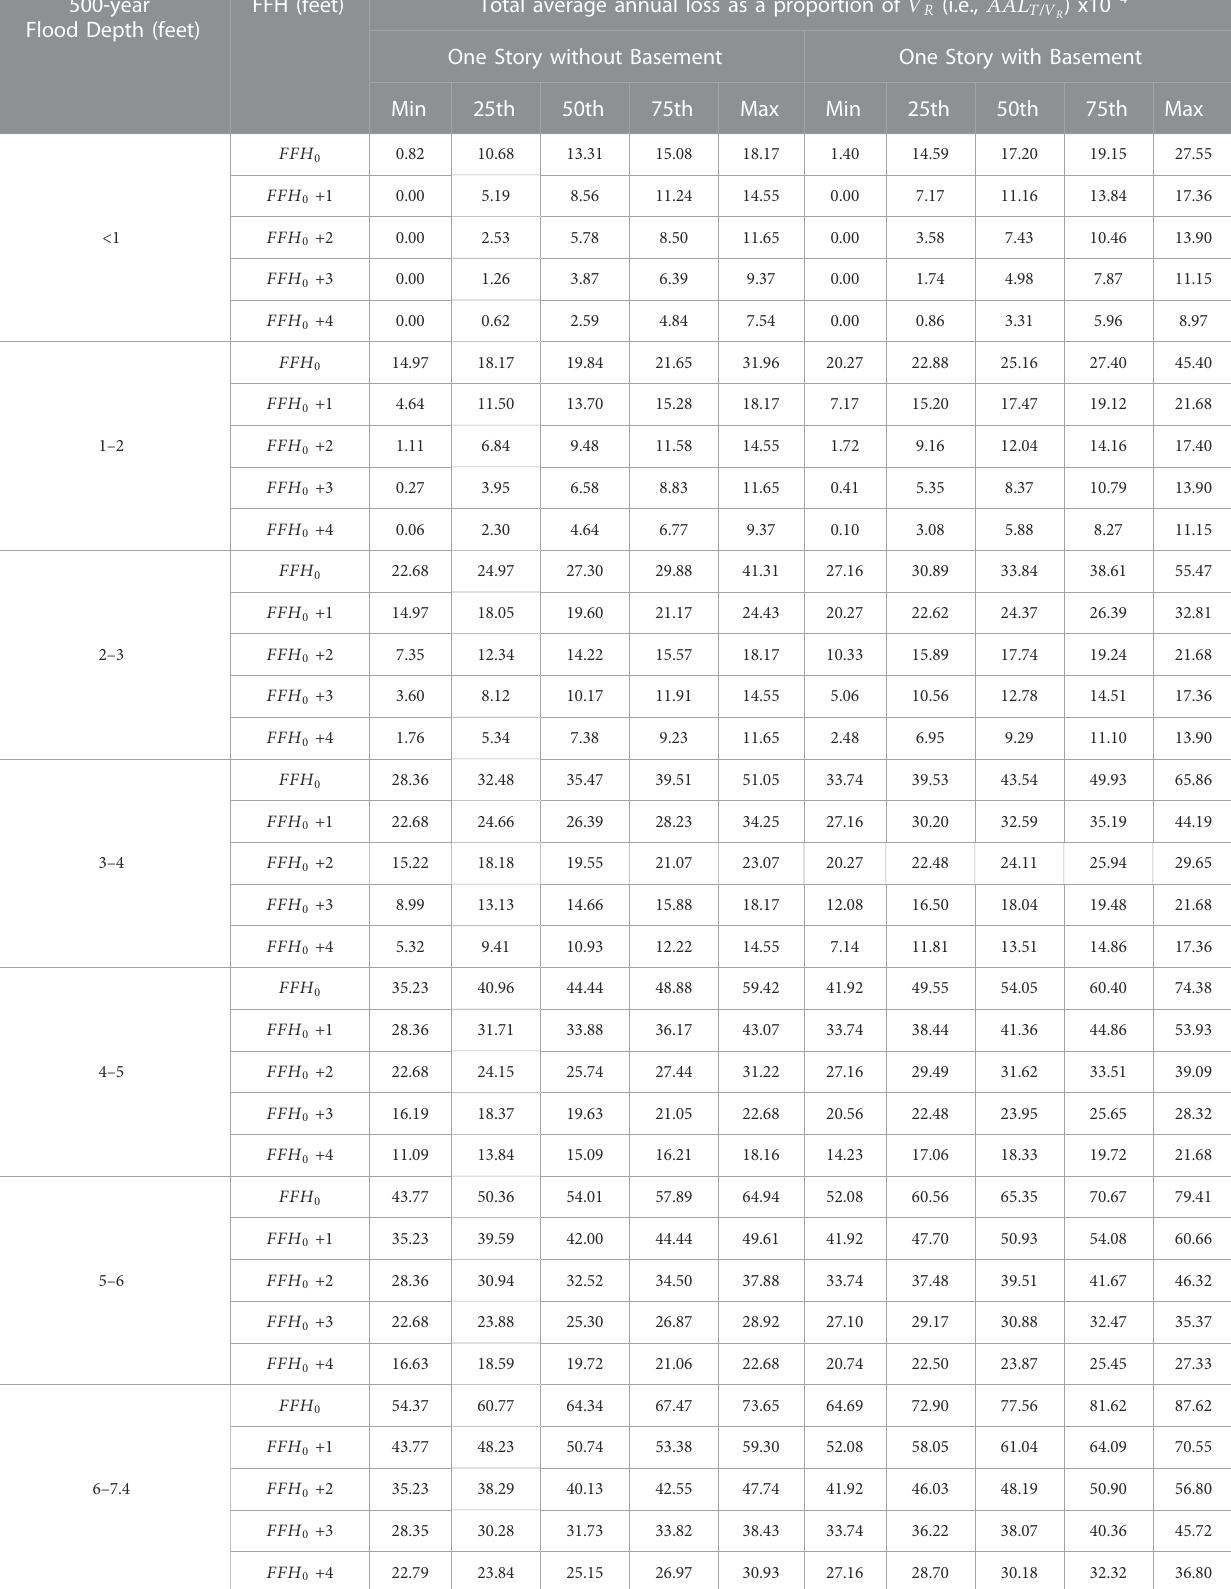
TABLE 3 Descriptive statistics of annual fl ood risk as a proportion of V R (i.e., AAL T / V R ) for slab-on-grade one-story single-family home with and without basement using synthetic data, categorized based on 500-year fl ood depth. 500-year Flood Depth